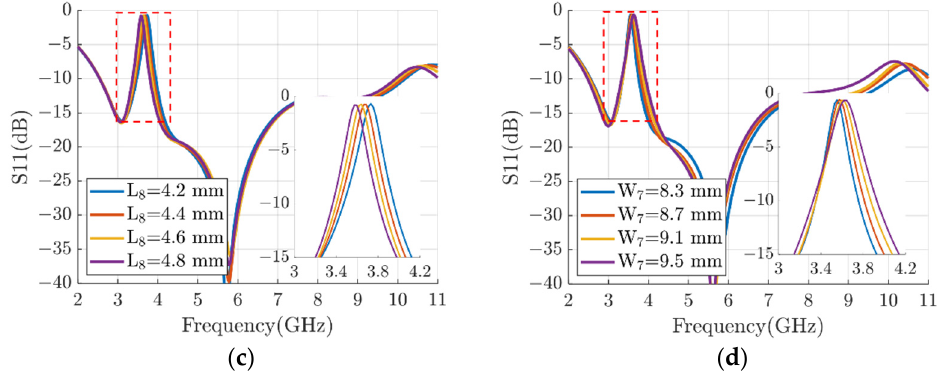
Figure 10. Simulated of the proposed antenna under different values of tail branches of the curled C-shaped slot. ( a ) VSWR under different Length L 8 . ( b ) VSWR under different Distance W 7 . ( c ) S11 under different Length L 8 . ( d ) S11 under different Distance W 7 .